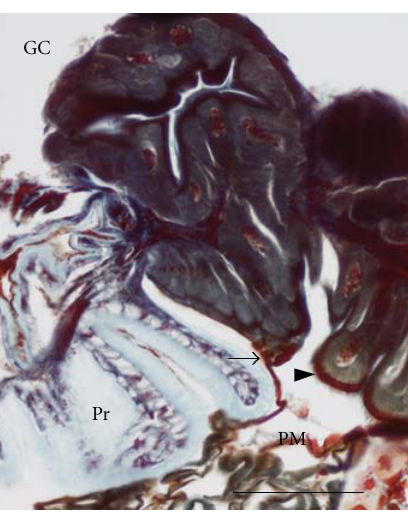
Figure 10: Junction of the foregut (left) and midgut (right) showing the proventriculus (Pr), a gastric caecum (GC), and the origin (arrow) of the peritrophic membrane (PM). The anterior cells of the midgut also appear to contribute secreted material (arrowhead) to the peritrophic membrane. Scale bar = 0.1mm.